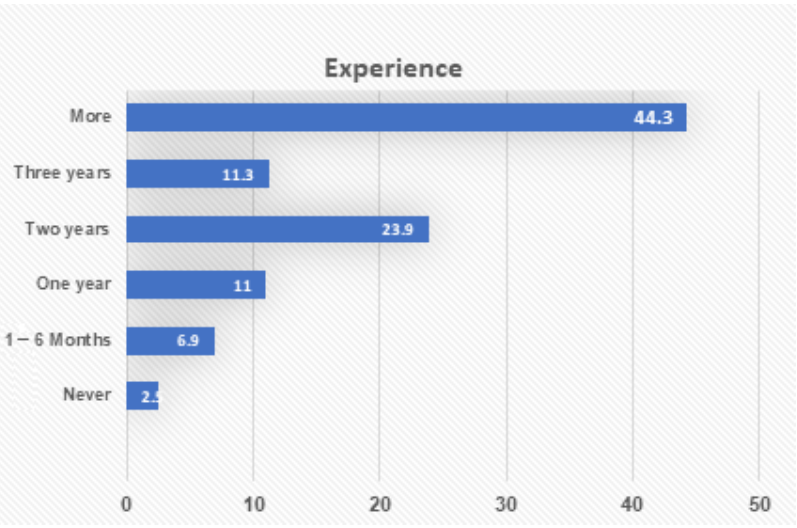
Figure 3. Respondents by